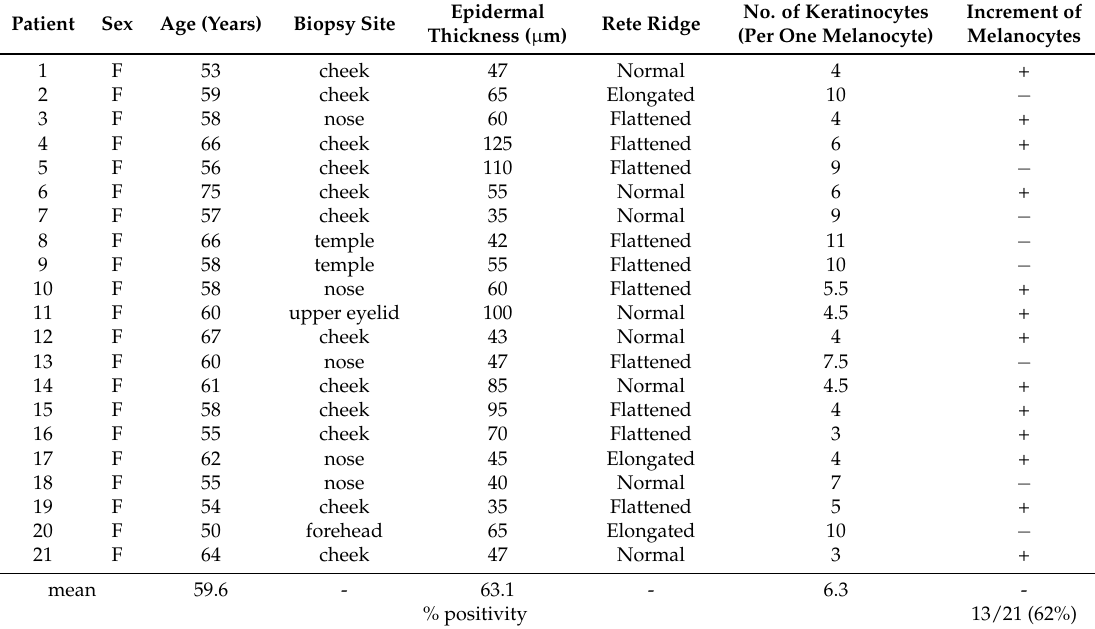
Table 1. Summary of histopathological findings in 21 solar lentigo (SL)